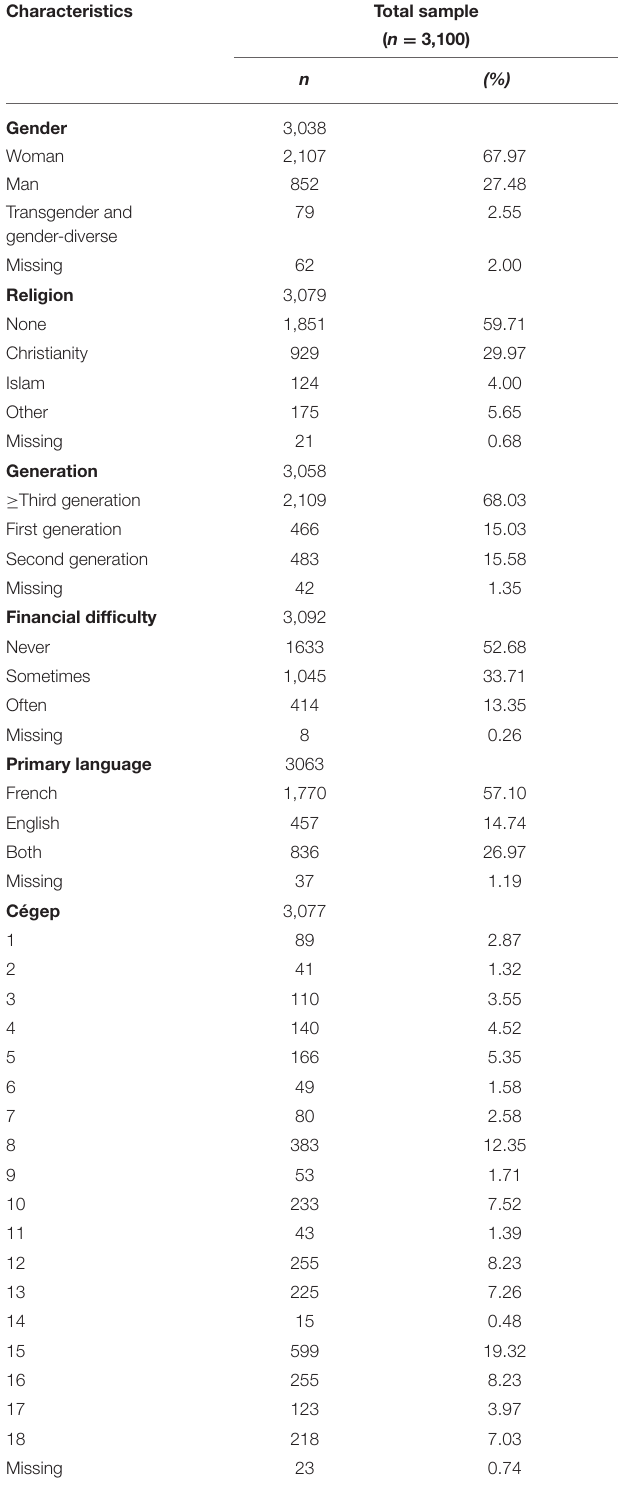
TABLE 1 | Socio-demographic characteristics of participants and descriptive statistics of study variables for the total sample ( n = 3,100).